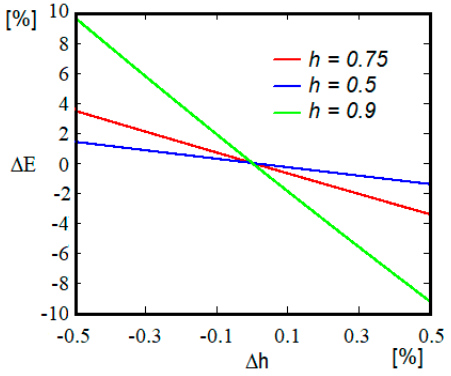
Figure 2. Influence of the measurement error ∆ℎ on the value longitudinal modulus.